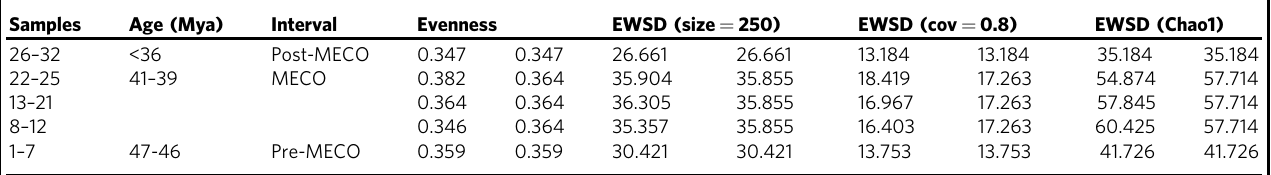
Table 1 Diversity estimators derived from spore-pollen records from southern Patagonia.